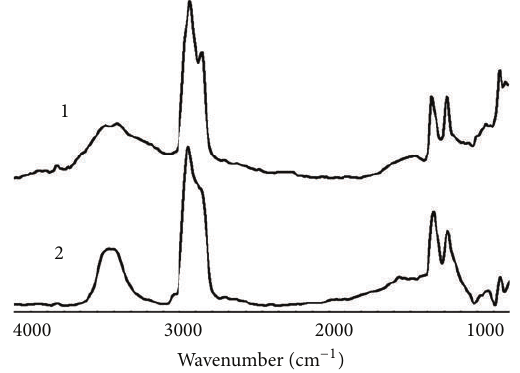
Figure 4: FTIR spectrum of cholesterol spot (trace 1) on a narrow- band TLC plate. For comparison, a reference FTIR spectrum (trace 2) of pure cholesterol is also